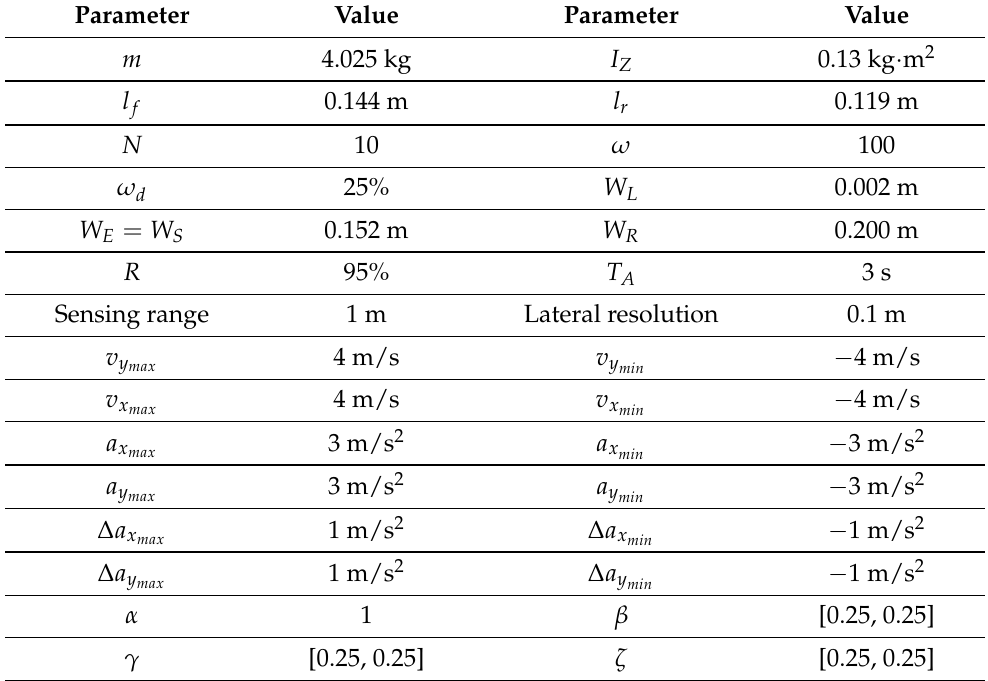
Table 3. Controller